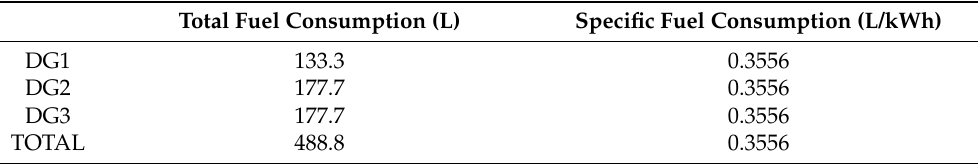
Table 6. DG units total and specific fuel consumption for off-grid operation (case with a single DG unit